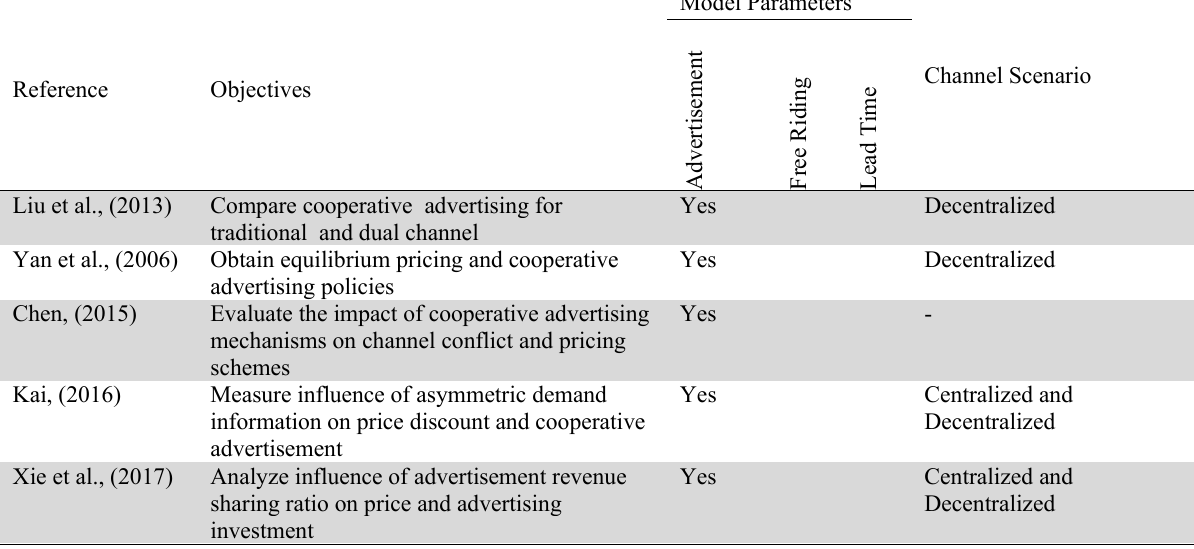
A comparison of current model with existing dual supply chain models